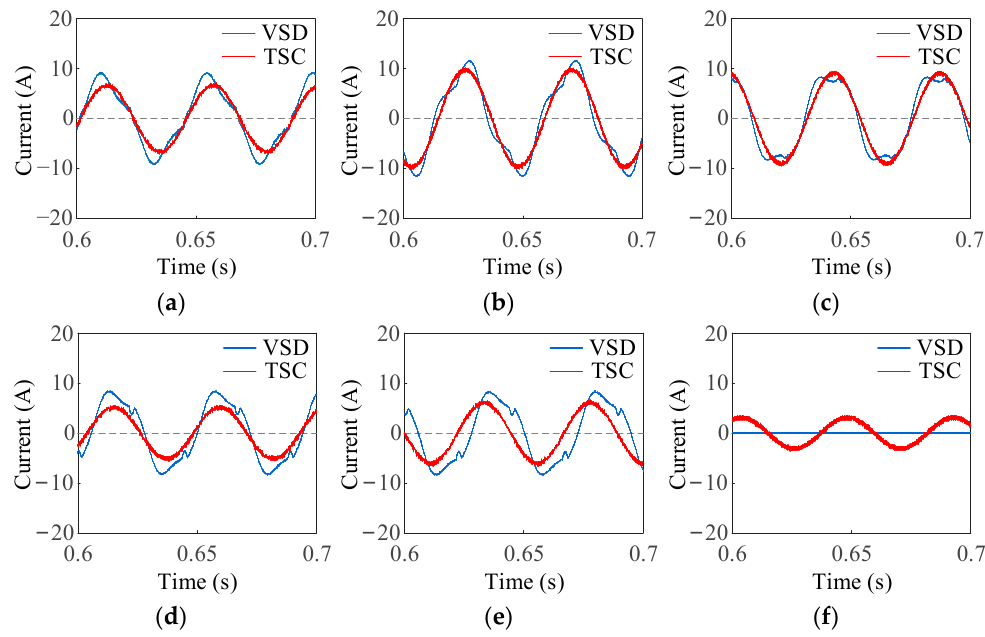
Figure 9. Phase currents for the non-fault-tolerant decoupling control and the TSC fault-tolerant control. ( a ) Phase A. ( b ) Phase B. ( c ) Phase C. ( d ) Phase X. ( e ) Phase Y. ( f ) Phase Z.